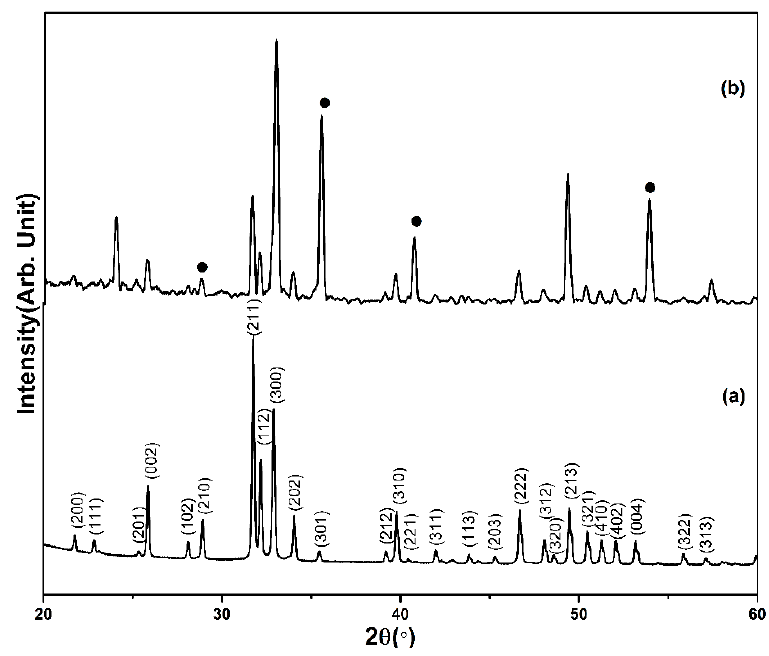
Figure 1. XRD pattern of ( a ) HAP and ( b ) HAP-MnFe 2 O 4 nanocomposite.